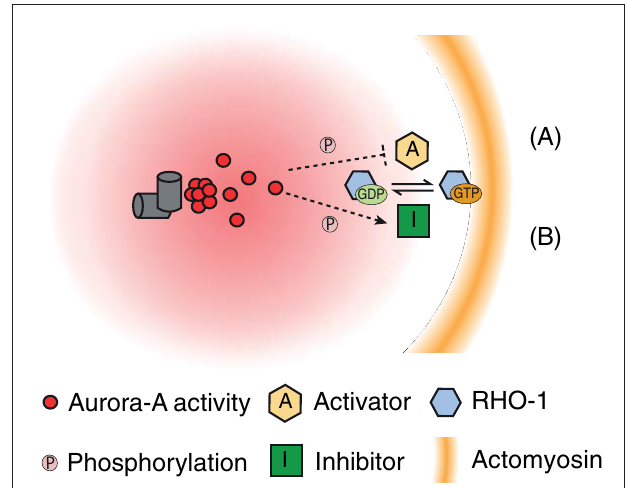
FIGURE 2 | Possible working models of AIR-1 transmission of actomyosin-derived inhibitory signals from the centrosome to the cortex during SB. AIR-1 is speculated to diffuse from the centrosome to the cortex, which may form a gradient of AIR-1 activity centered around the centrosome.